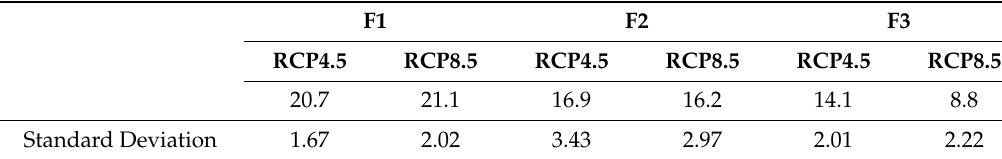
Figure 5. Change in 20-year return period (years) of AMDP for 25 CMIP5 GCMs for the F1, F2, and F3 periods under RCP4.5 and RCP8.5. ( a ) F1 under RCP4.5, ( b ) F2 under RCP4.5, ( c ) F3 under RCP4.5, ( d ) F1 under RCP8.5, ( e ) F2 under RCP8.5, and ( f ) F3 under RCP8.5. Table 3. Future change in 20-year return period.